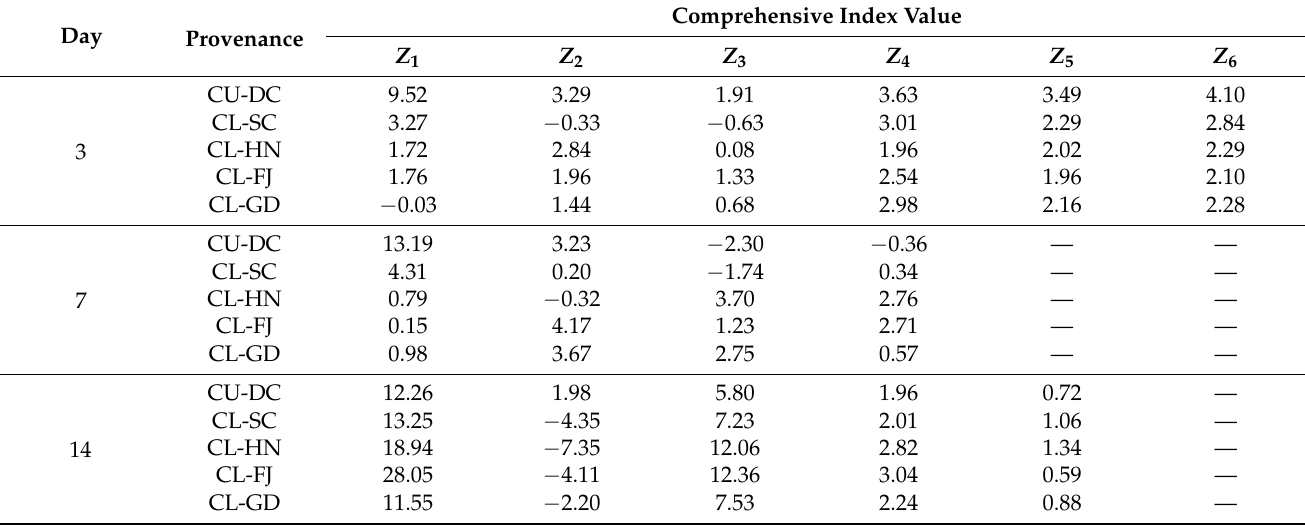
Table 1. Comprehensive index values of Cunninghamia. unica and C. lanceolata .